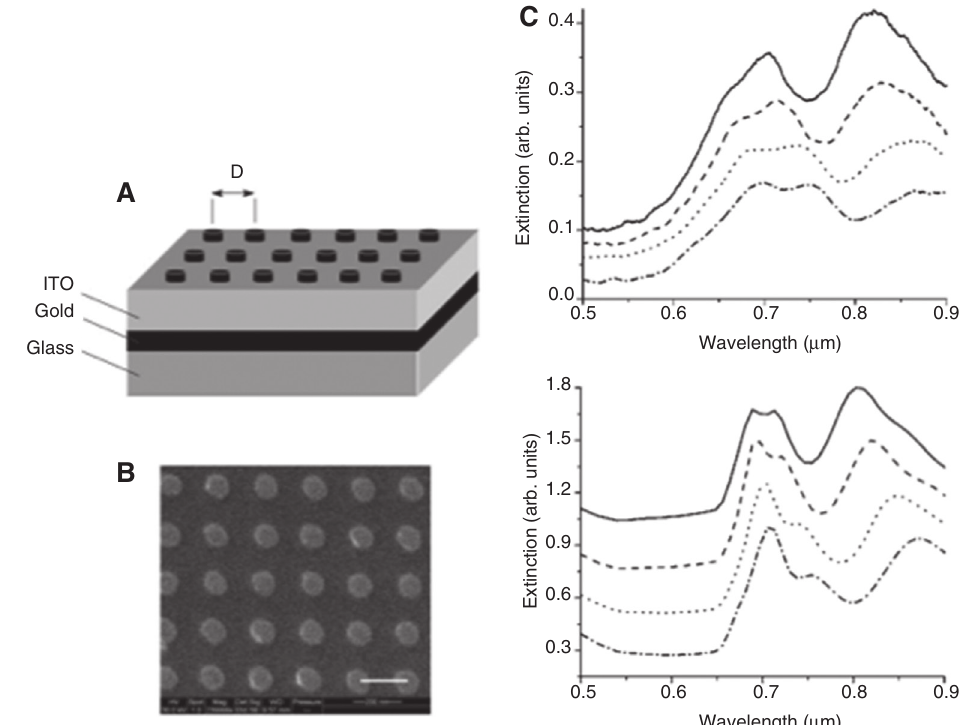
Figure 12: (A) Schematic description of the sample and (B) scanning electron micrograph of the top side (scale bar of 200 nm). (right) Extinction spectrum evolution with pitch D for the system (gold particle grating/ITO/gold layer). (C) Experimental, (D) theoretical. In both cases the curves have been translated vertically for further clarity. Reprinted figure with permission from J. Cesario, R. Quidant, G. Badenes and S. Enoch, Opt. Lett., vol. 30, no. 24, pp. 3404–3406 (2005). Copyright 2005 by the Optical Society